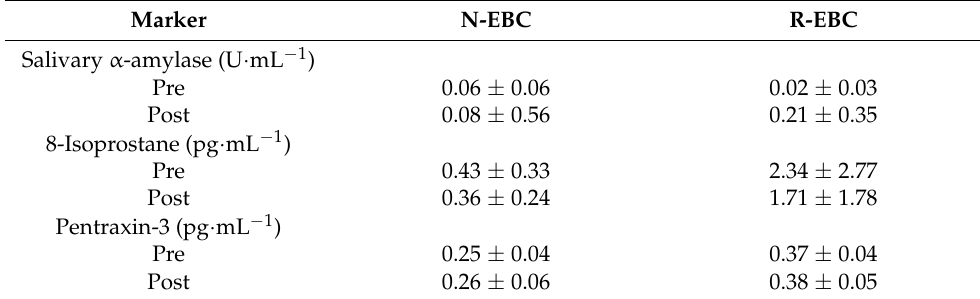
Table 3. Variables of Oxidative